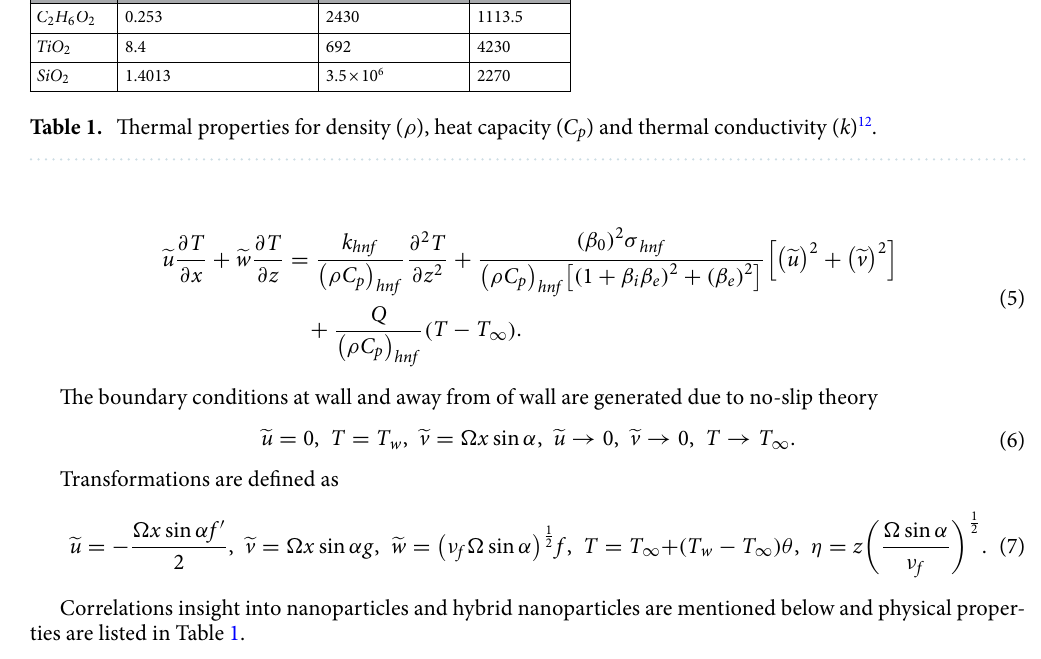
k (thermal conductivity) C p (heat capacity) ρ (density)